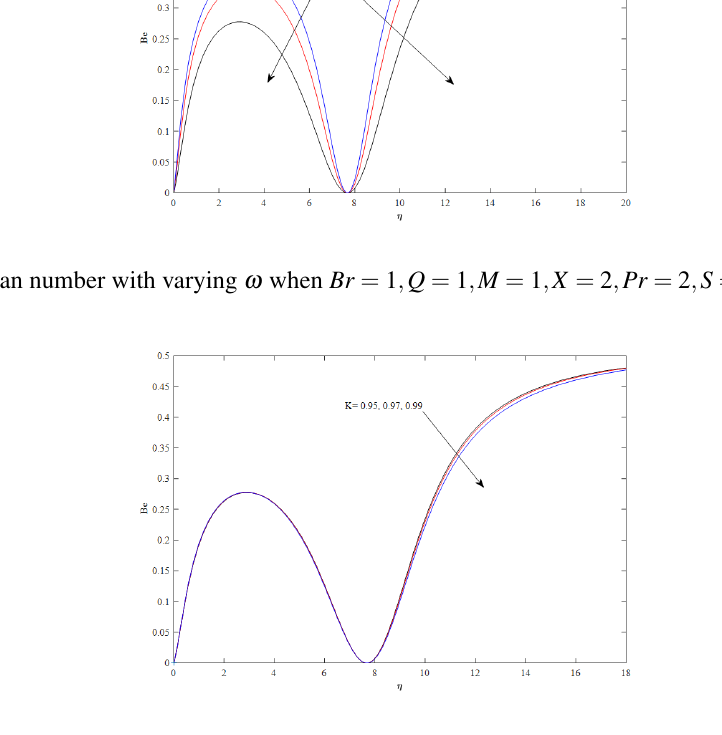
Fig. 12 Bejan number with varying K when Br = 1 , Q = 1 , M = 1 , X = 2 , Pr = 2 , S = 0 . 01 , ω = 1